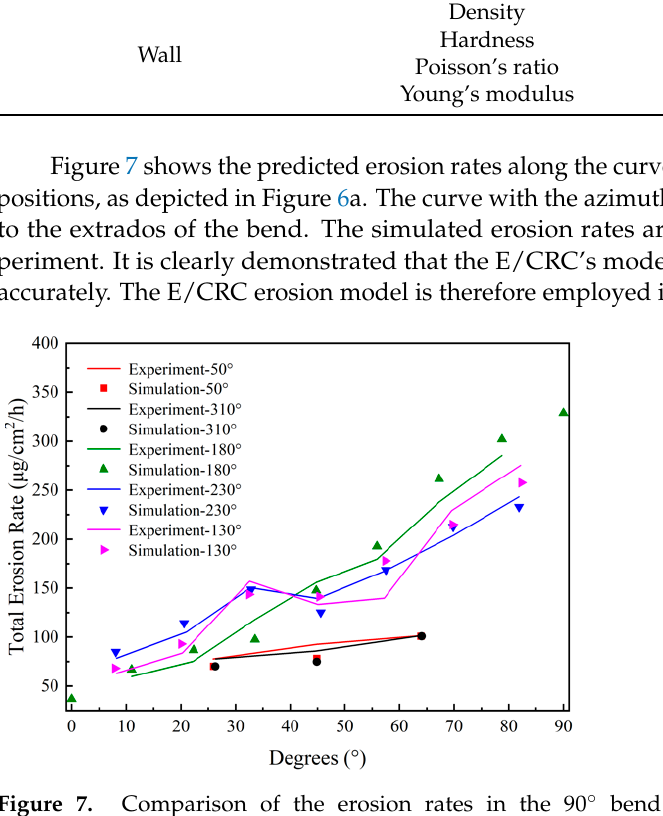
Figure 7. Comparison of the erosion rates in the 90° bend between the simulation and experimental results. Table 3. Parameters used in the simulation of erosion model validation.